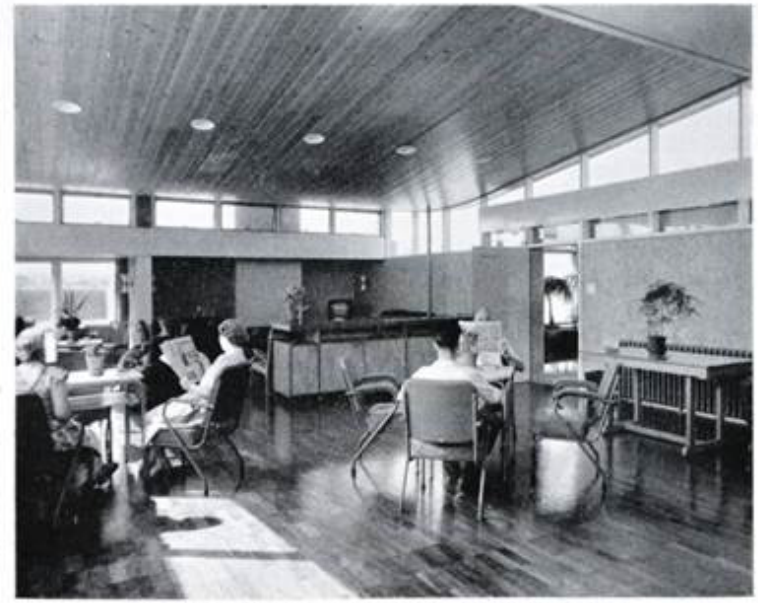
Figure 6. Admission and Treatment Unit, Fair Mile Hospital, Wallingford, Oxfordshire, common room, c . 1959 (Source: ‘Into the Light’, Fair Mile Hospital staff recruitment booklet, 1959, P/HA2/5/1, Berkshire Record Office, Reading, Berkshire,